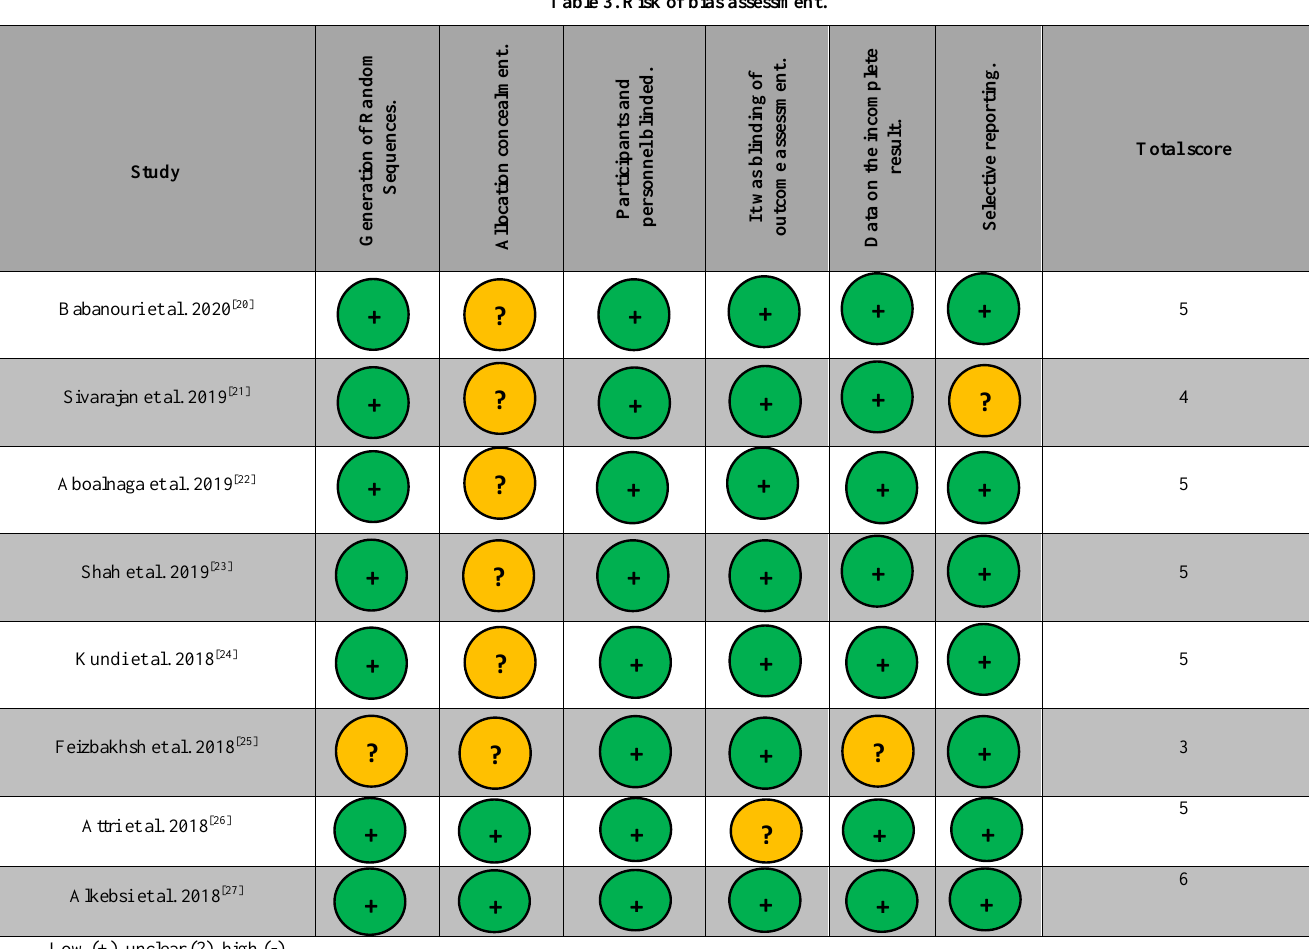
Table 3. Risk of bias assessment.